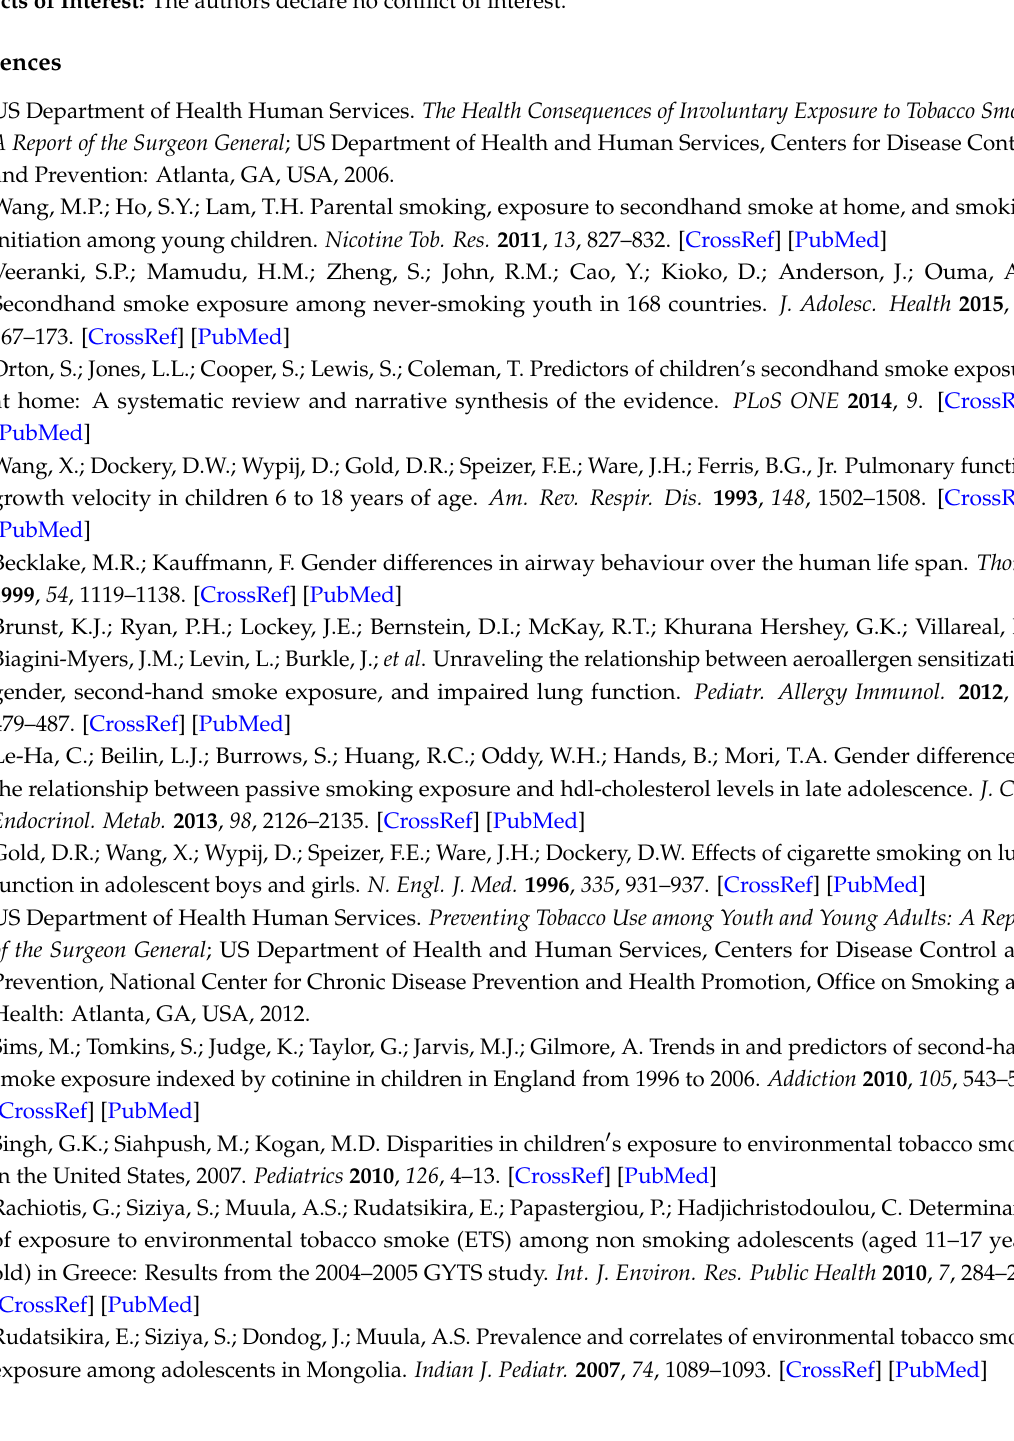
Table S1. The original Korean version of core